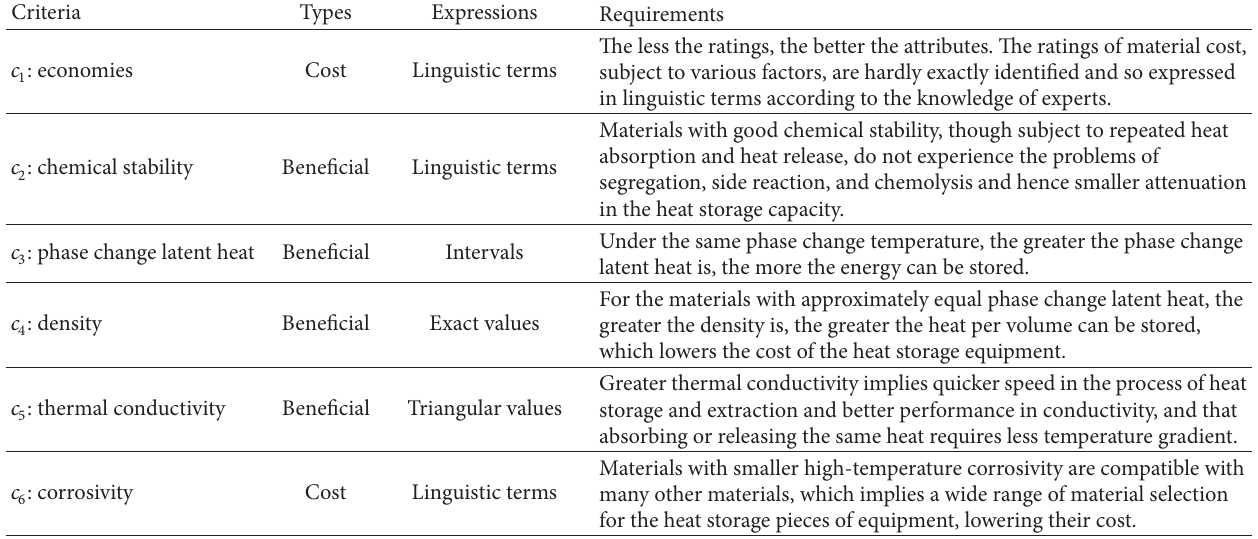
Table 1: Criteria’s types, expressions, and